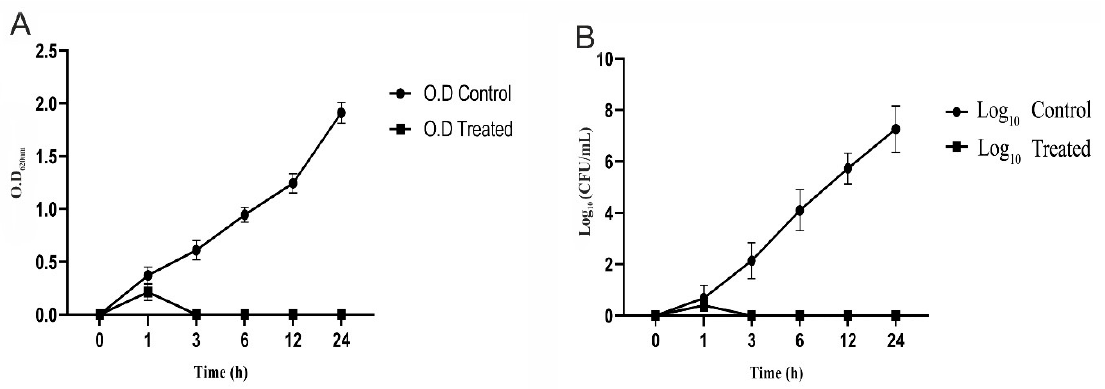
Figure 7. Challenge of a CoNS culture ( S. haemolyticus CFS43 and S. epidermidis CFS79) with CoNShP-3 phage at 37 °C. ( A ) in broth medium of TSB (measurements of OD 620 nm ), and ( B ) in the solid medium of TSA (measurements of colonies count CFU/mL).